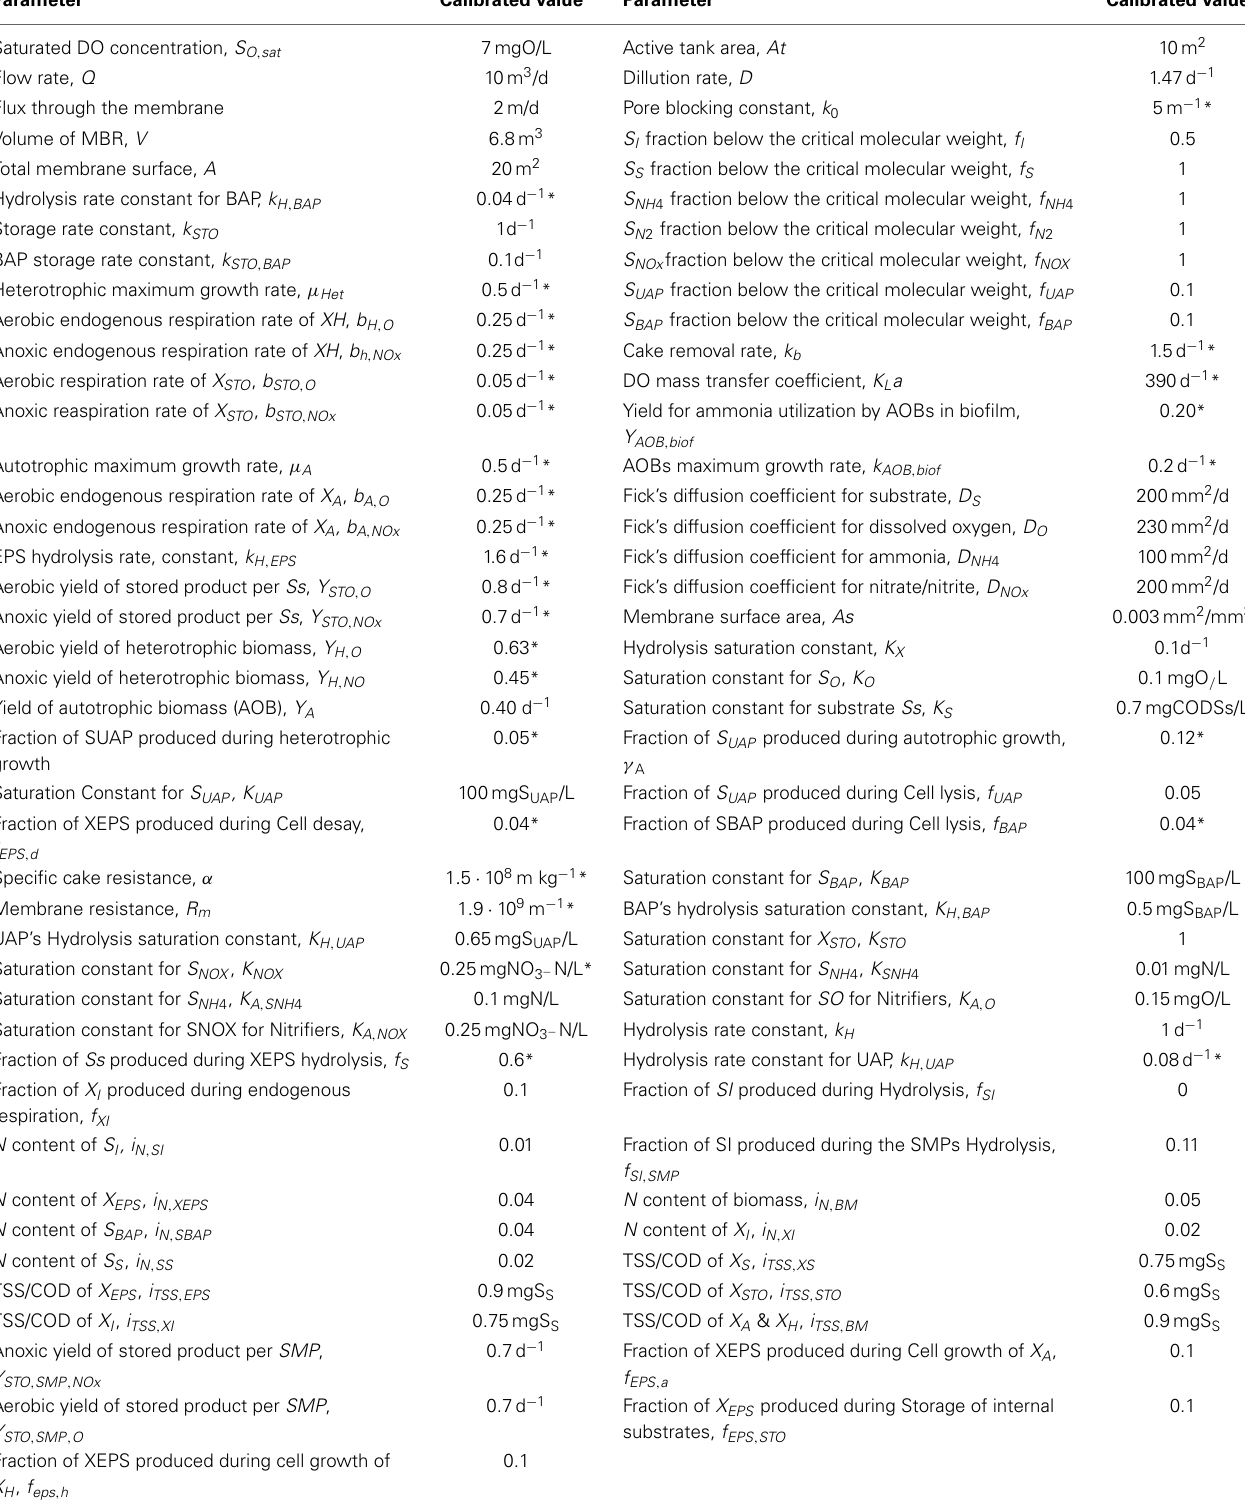
Table 6 | Model parameter